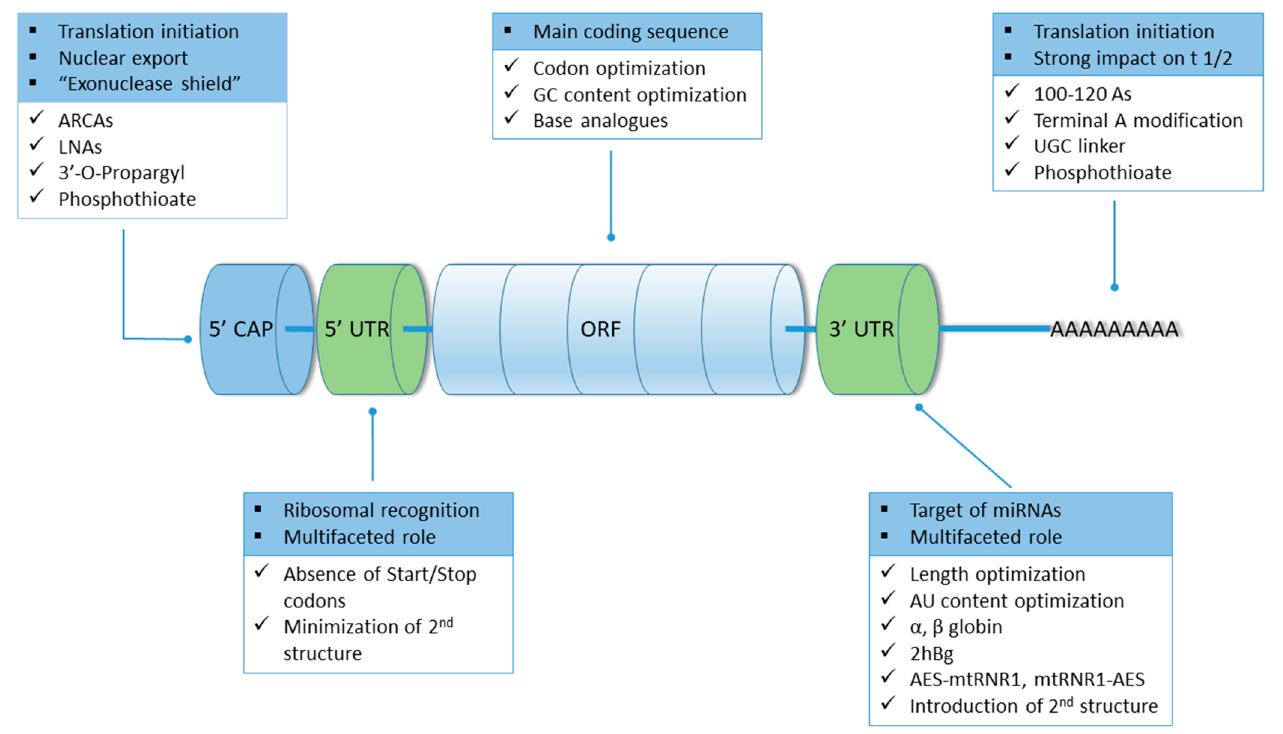
Figure 4. Structural elements of mRNA, their role and modifications impacting mRNA viability as a therapeutic. The main role of each element (5 ′ cap, 5 ′ and 3 ′ UTRs, ORF, Poly(A) tail) is given by a square bullet, whereas the modifications pertaining to its modification is given with checkmarks .